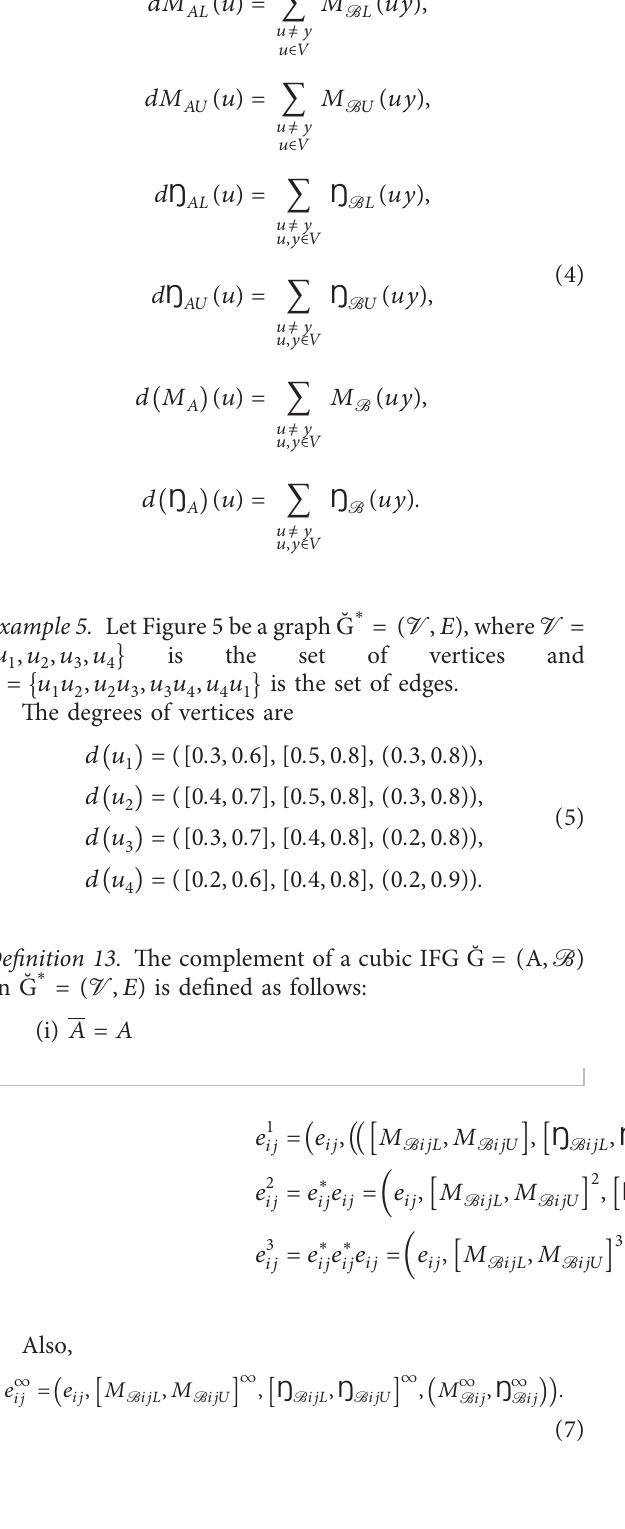
Figure 5: Cubic intuitionistic fuzzy